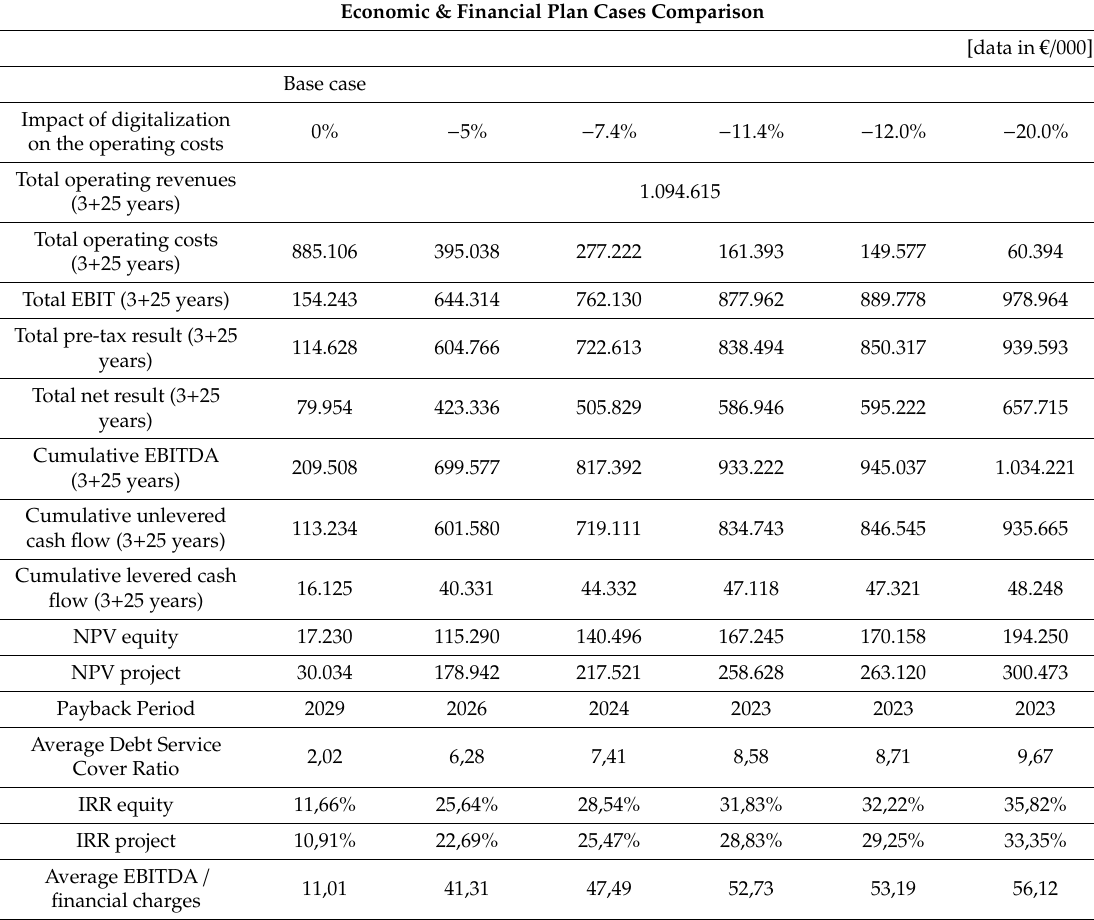
Table 2. Impact of digitalization on the economic and financial margins of a healthcare PPP investment (data in € /